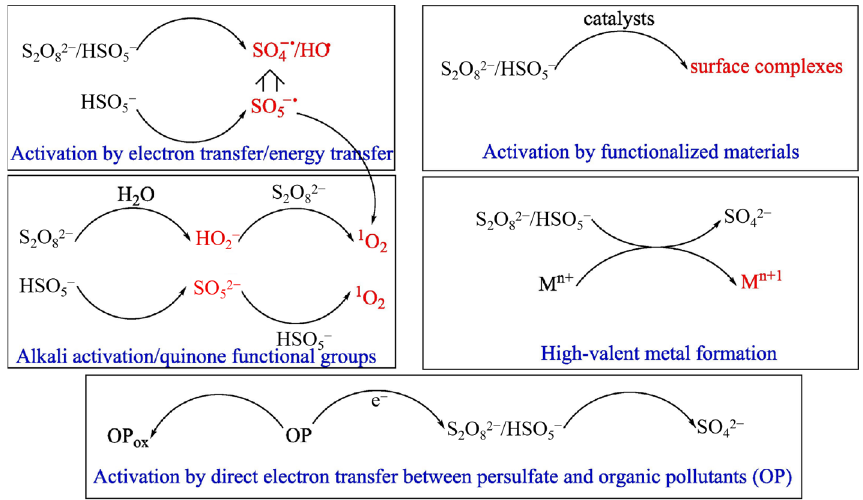
Figure 6. Possible activation mechanisms of persulfate. Reproduced with permission from [78].